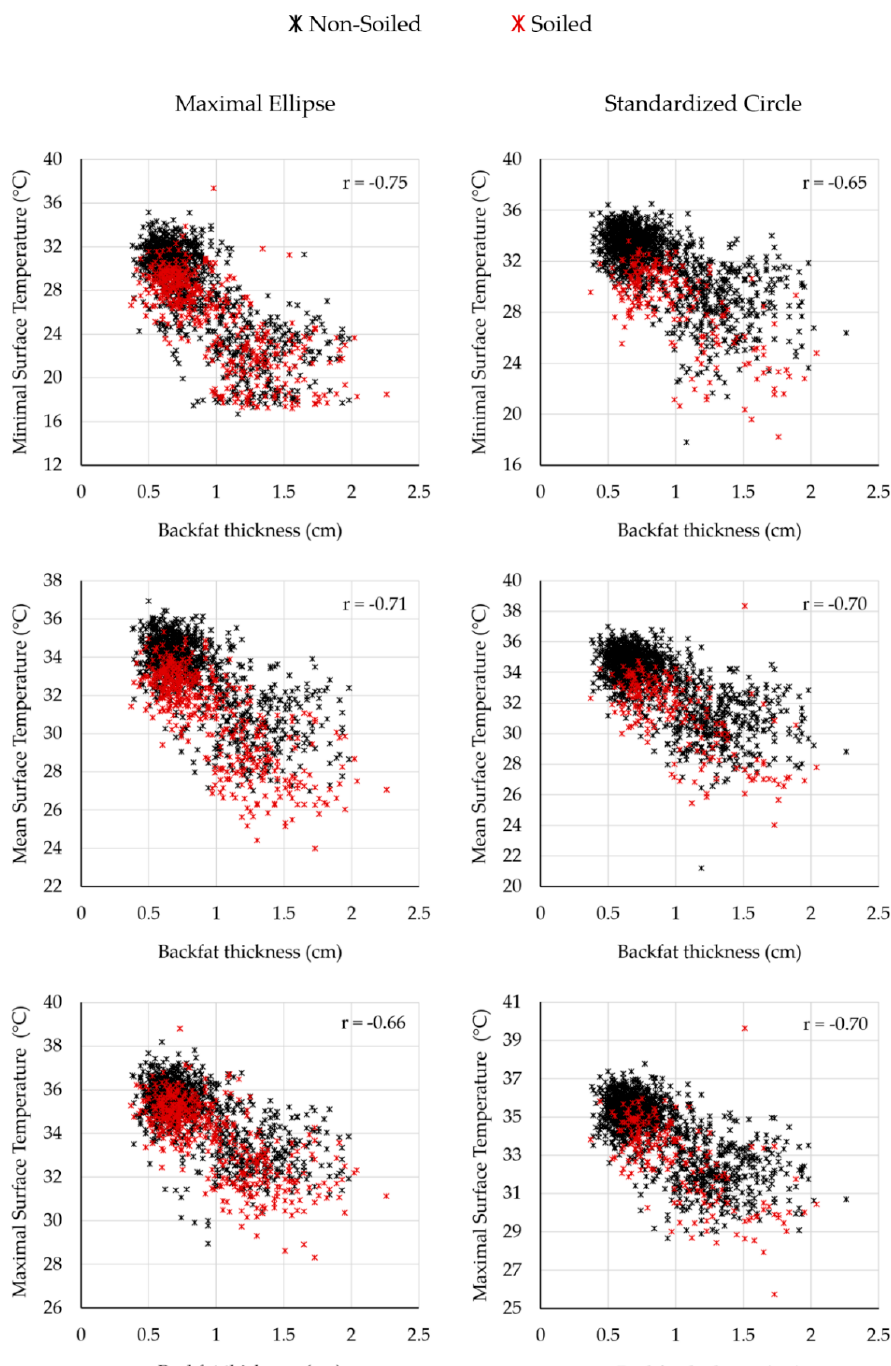
Figure 6. Correlation between body surface temperature ( ◦ C) and backfat thickness (cm) for soiled and non-soiled animals with n = 1457 in total. Left column: evaluation method ME; right column: evaluation method SC ( p < 0.001).